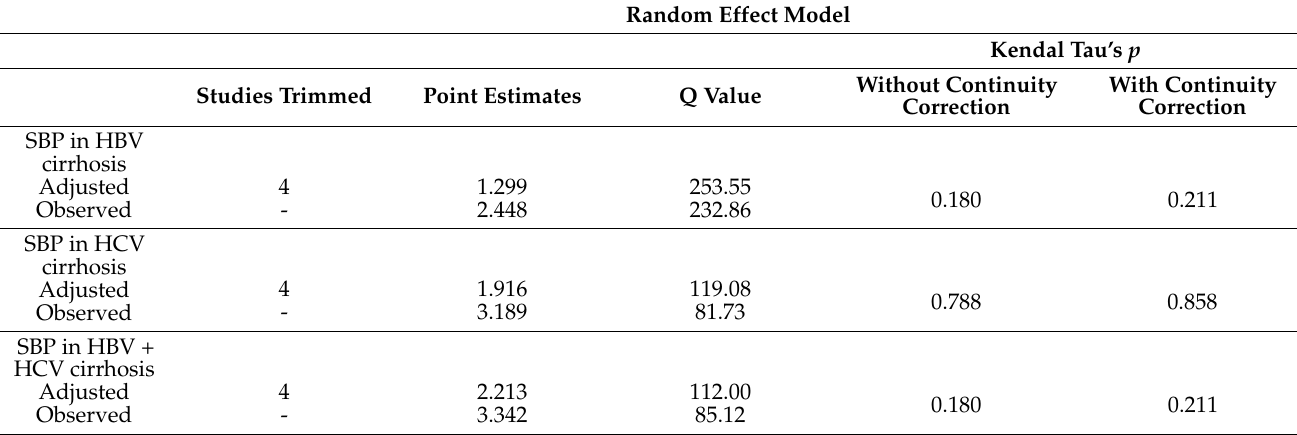
Table 2. Tau statistic and point estimate.